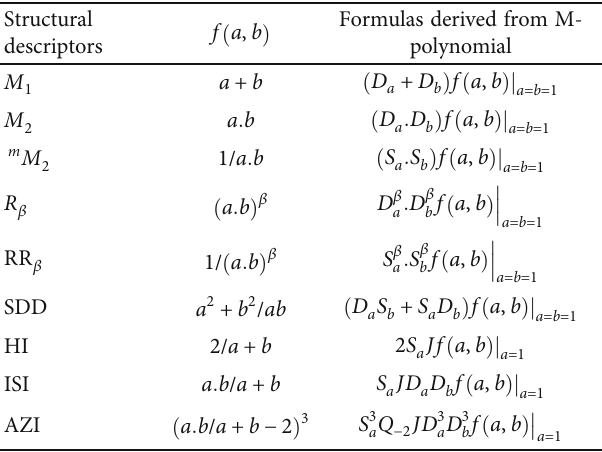
Table 1: Formulas of certain signi fi cant structural descriptors based on M-polynomial.